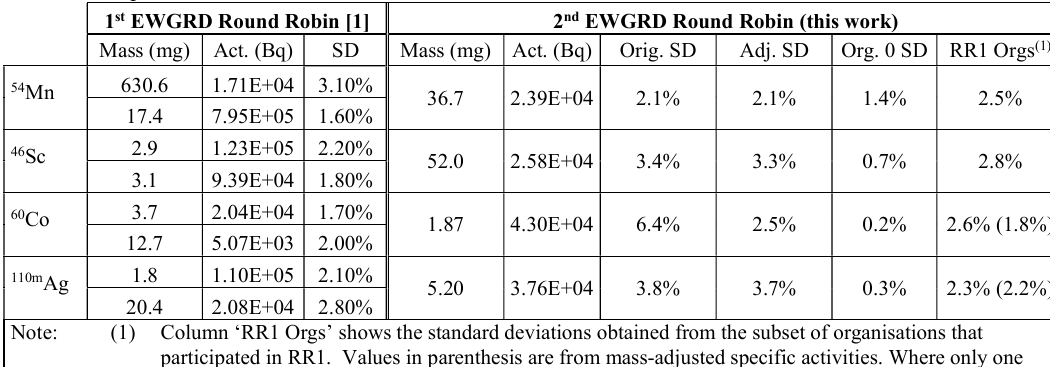
Table 4 Comparison of the Results from the Current Work with the First EWGRD Round Robin 1 st EWGRD Round Robin [1] 2 nd EWGRD Round Robin (this work) Mass (mg) Act.